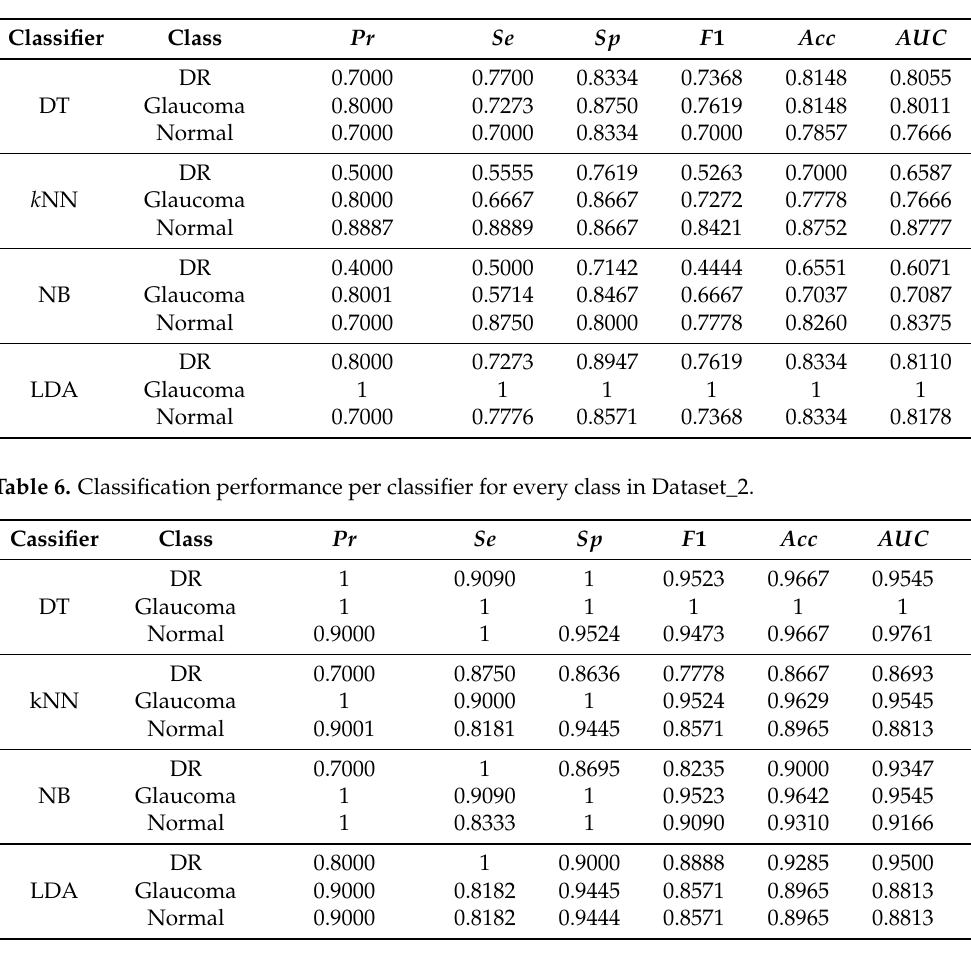
Table 5. Classification performance per classifier for every class in the HRF dataset.